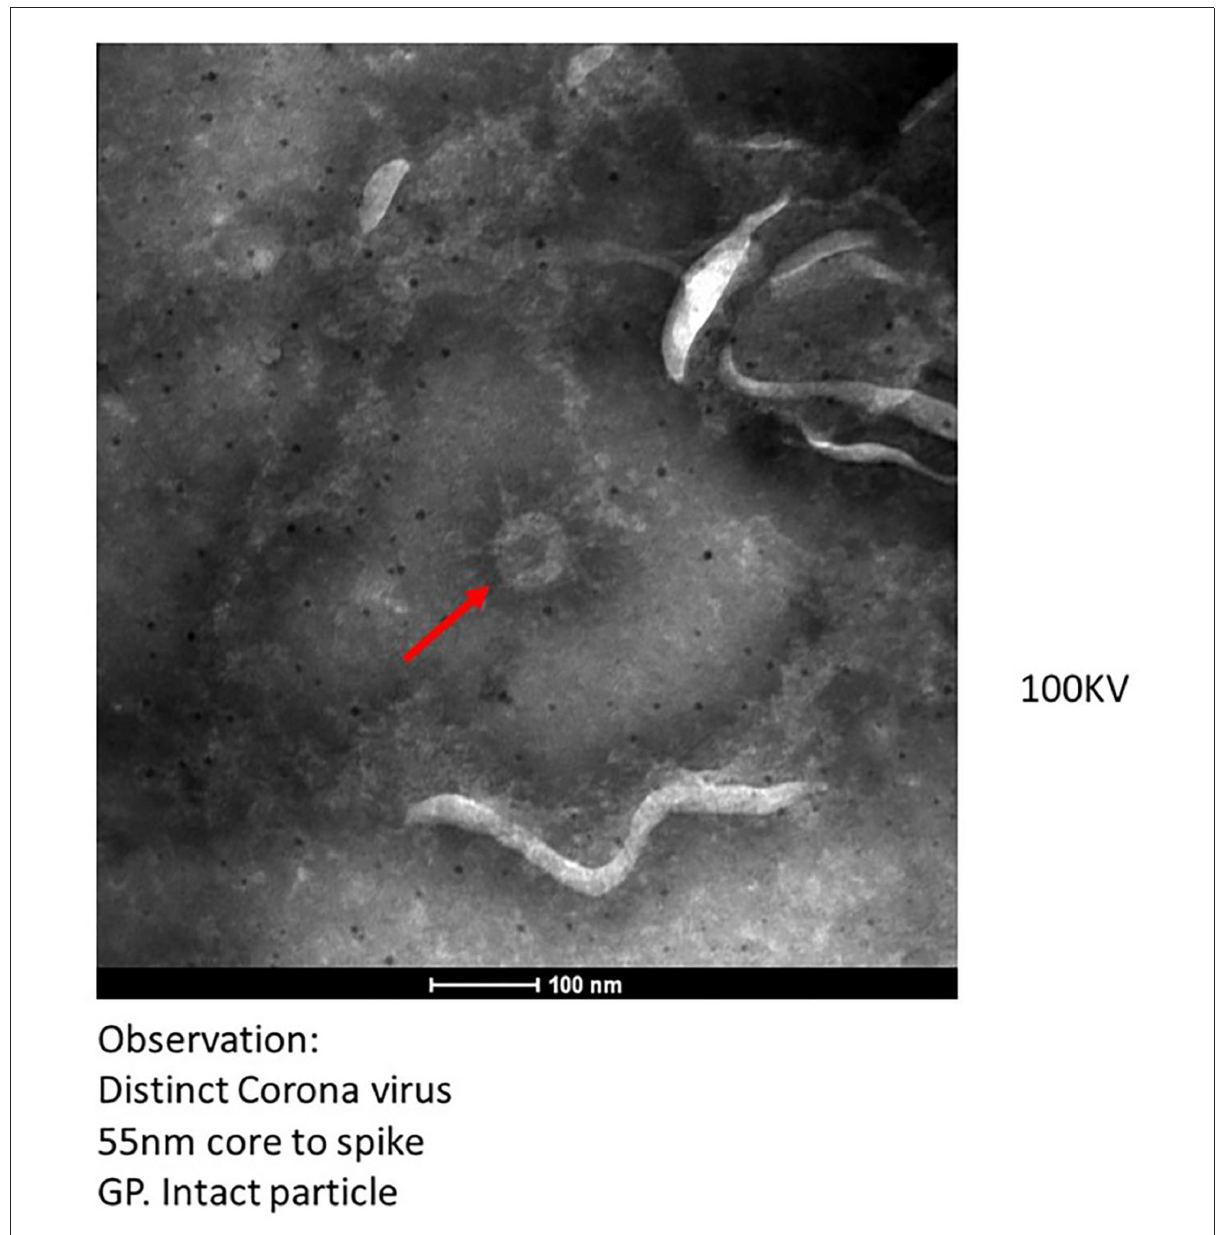
FIGURE1 Transmission electron microscopy imaging from fecal specimen of positive COVID-19